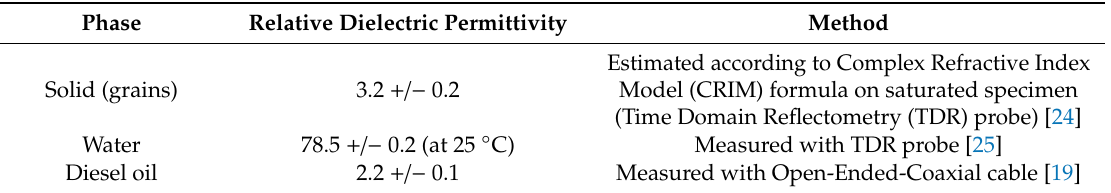
Table 2. Reference values of relative dielectric permittivity for the materials adopted in the sensitivity